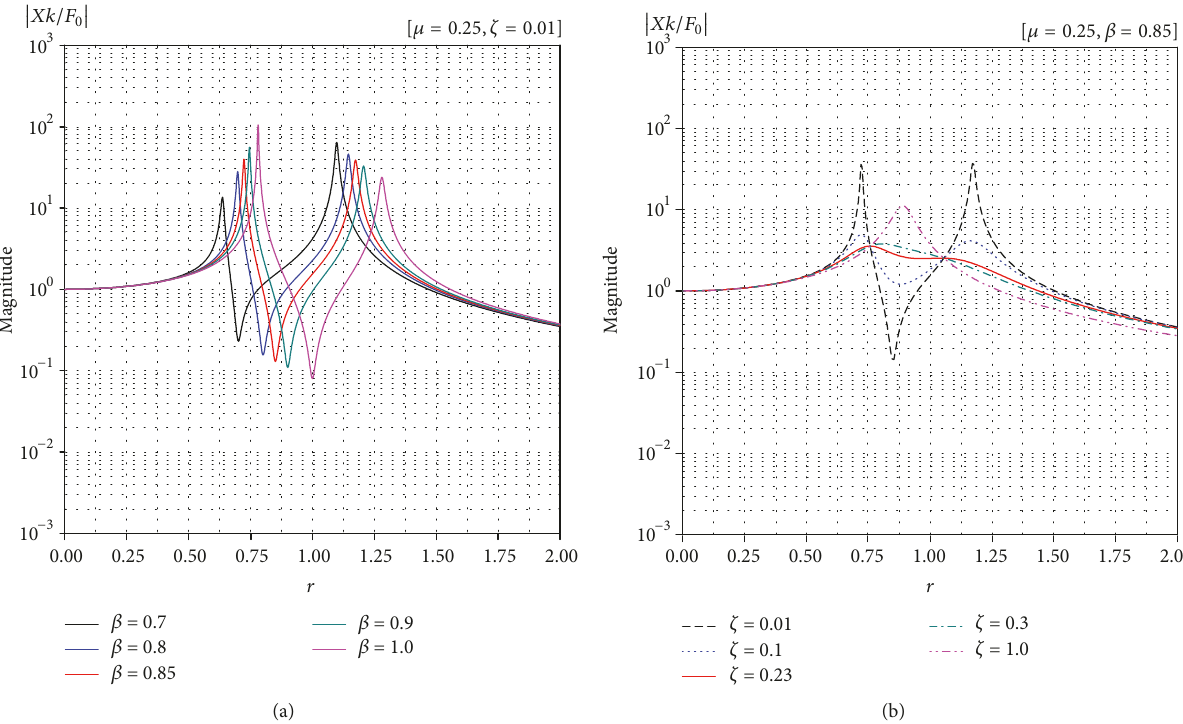
Figure 6: Normalized magnitude of the primary structure: (a) for various 𝛽 values when 𝜇 = 0.25 ; (b) for various 𝜁 values when 𝜇 = 0.25 , 𝛽 = 0.85 .